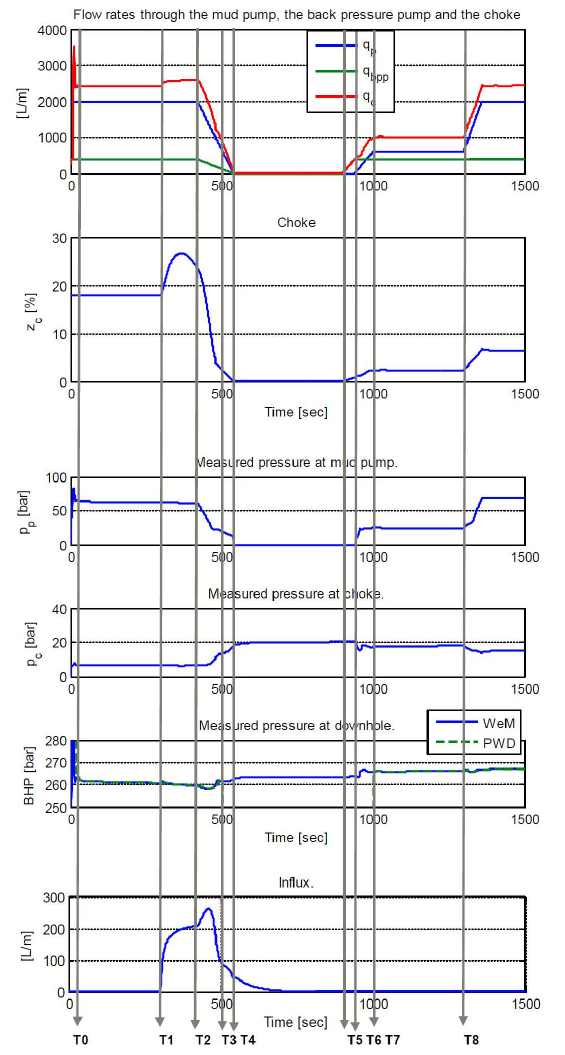
Figure 3: Case 1: Flowrates, choke opening, measured pressure and Influx flow rate using DSI on Well 1.